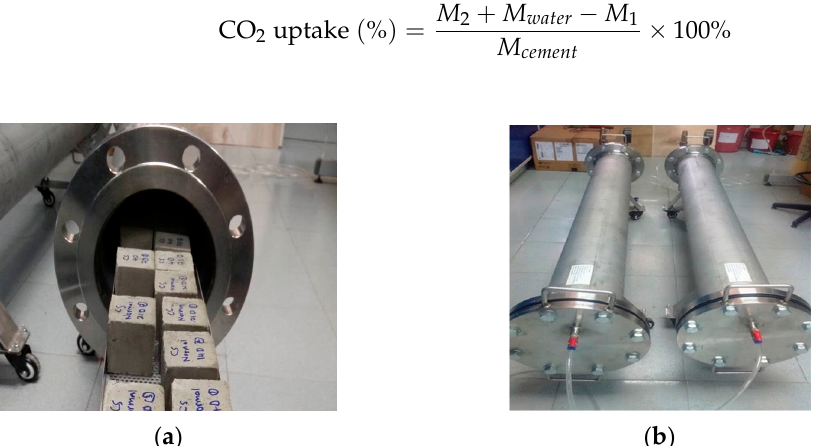
Figure 1. Carbonation curing process; ( a ) brick specimens undergo carbonation curing ( b ) carbona- tion chamber used in the experiment.